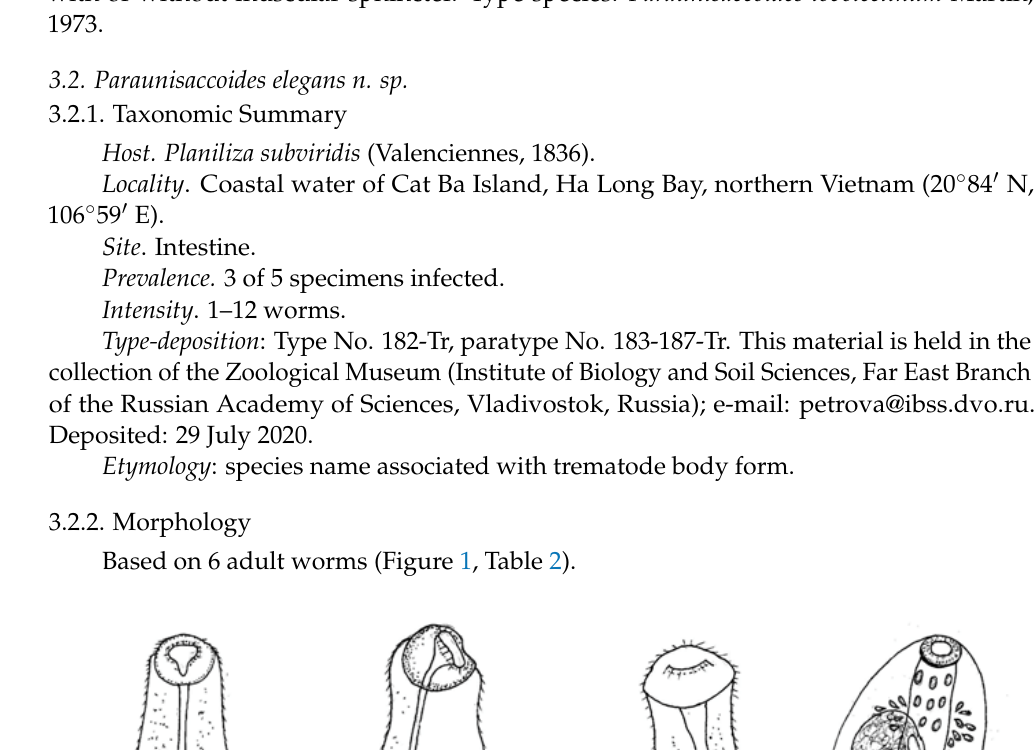
Paraunisaccoides elegans n.